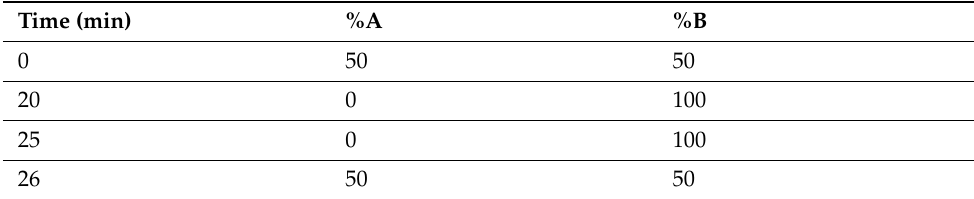
Table 9. Solvents used, % of solvent A and % of solvent B